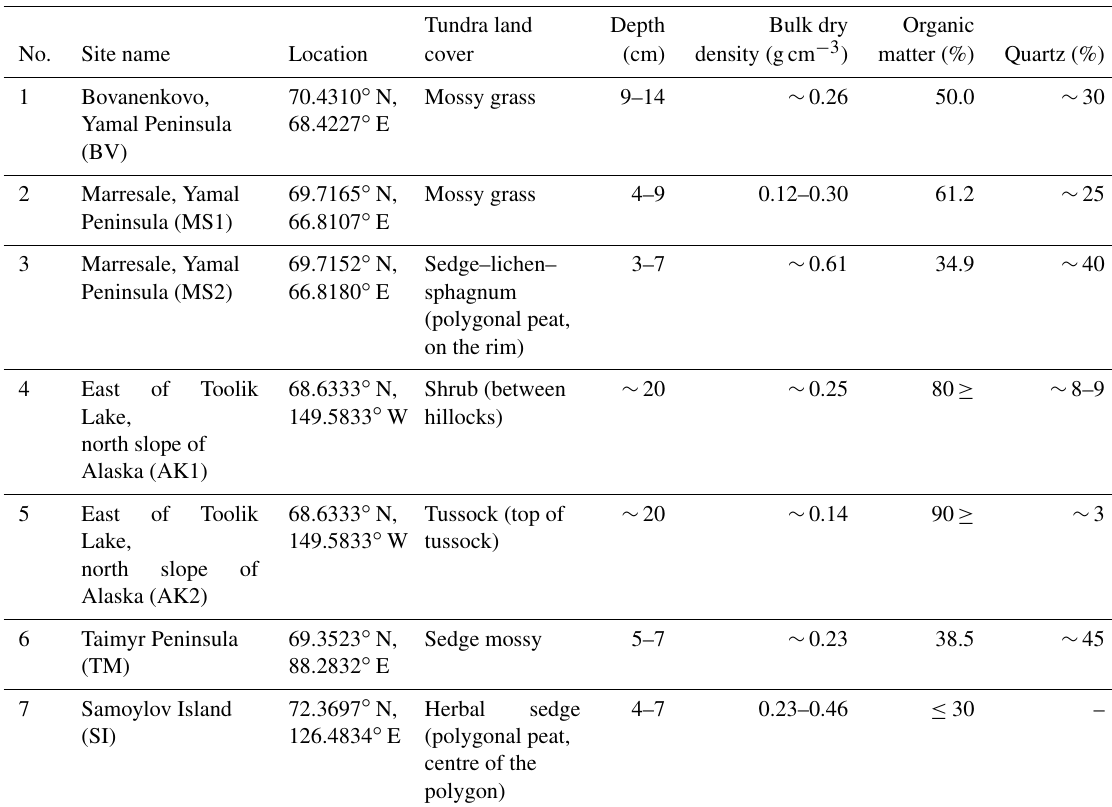
Table 1. Sampling points and geophysical characteristics of the studied soil samples. Tundra land Depth Bulk dry Organic No. Location